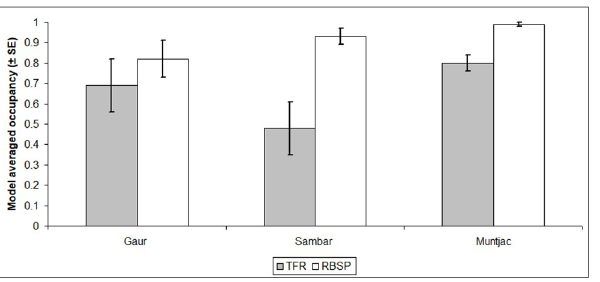
Fig 3. Model averaged occupancy ( ^ c ) estimates and corresponding standard errors (SE) for three focal ungulate species in Temengor Forest Reserve (grey bars) and Royal Belum State Park (white bars) [note: wild boar is excluded because its occupancy was close to 1.0].